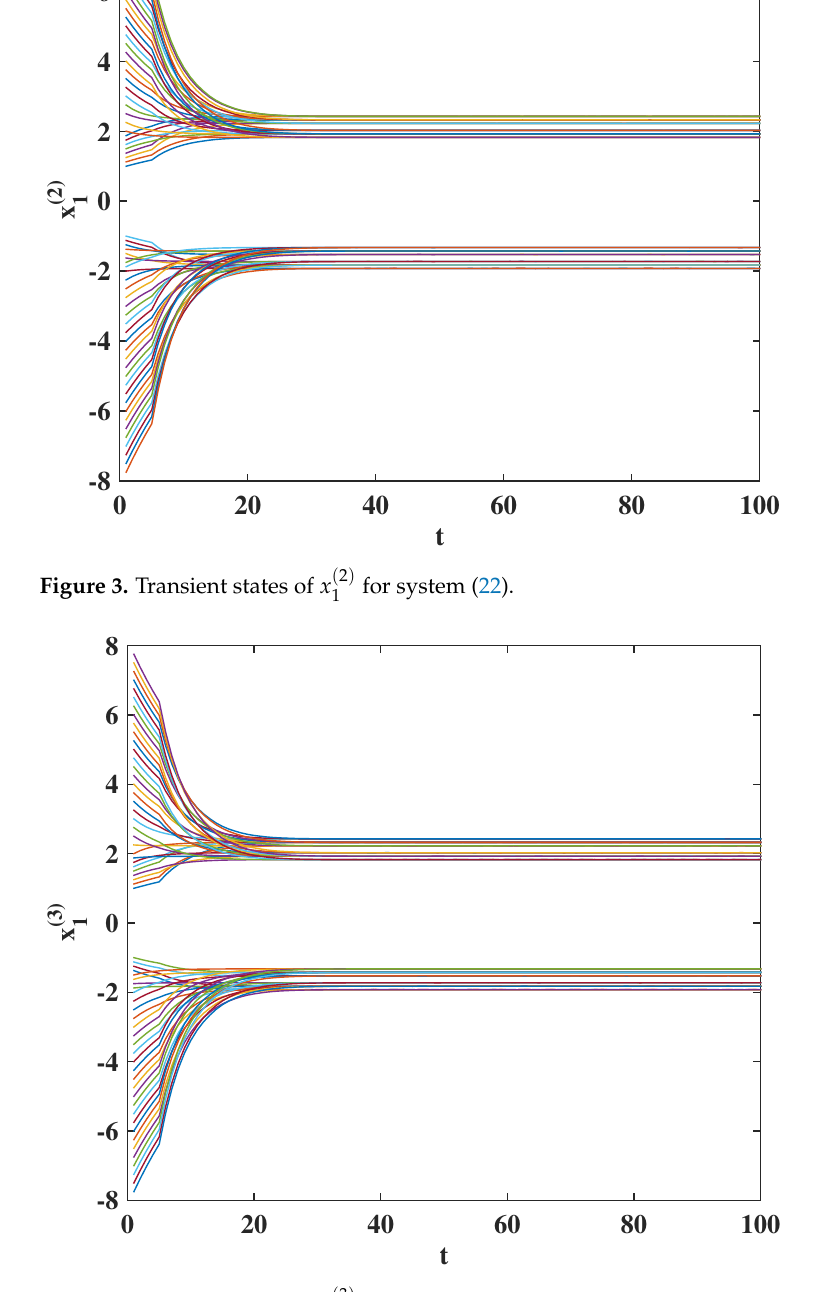
Figure 4. Transient states of x